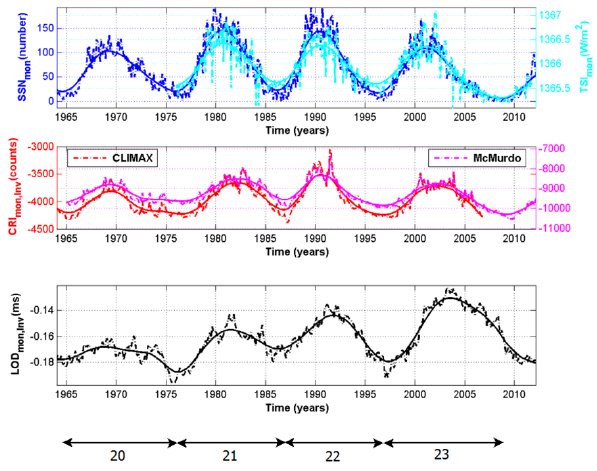
Figure 3. Original data and data smoothed by adjacent averaging (30 months) of SSN, TSI (Wm − 2 ) , CRI Inv (CLIMAX (red lines) and McMurdo (magenta lines)) and LOD Inv . The curves for the common time interval are presented. Solar cycles (from 20 to 23) are indicated at the bottom of the figure.